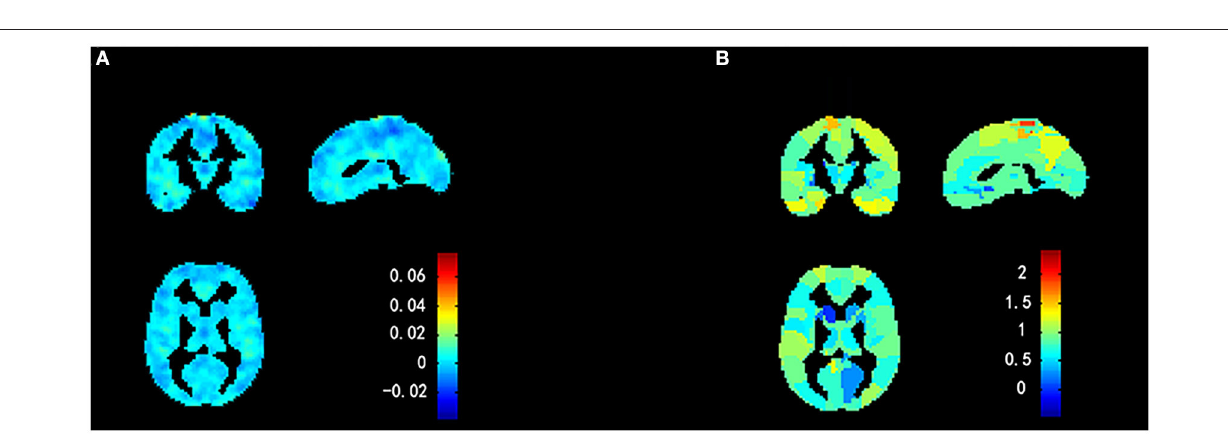
FIGURE 6 | Weight maps for classification model using a 2-fold cross-validation framework on whole sample. (A) Voxel-based predictive pattern. Color bar indicates weight of voxels for classification. (B) Region-based pattern localization map calculated from voxel-based predictive pattern showed in (A) . Color bar uncovers percent of weights that each anatomical region